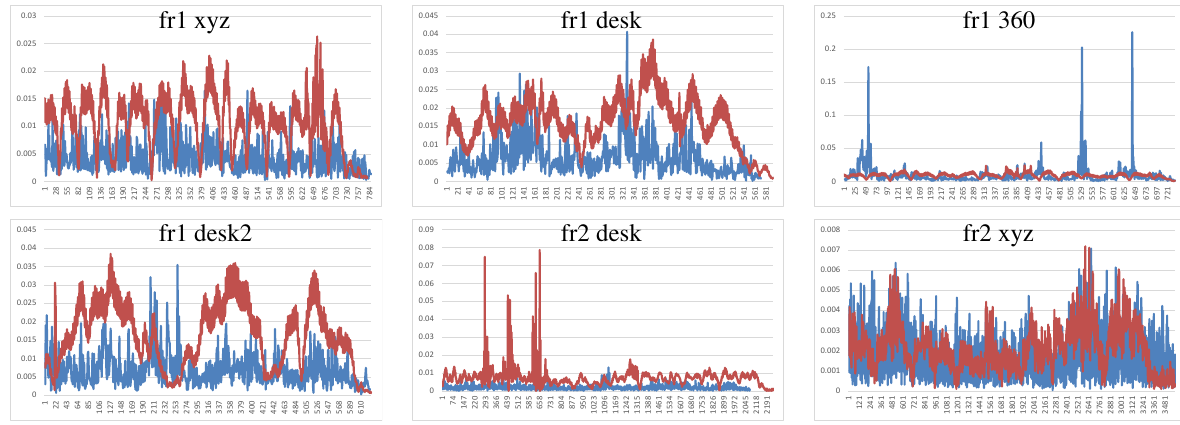
Figure 8. Dense visual odometry relative pose translational errors (y-axis, meters) on the selected datasets (x-axis, frames).